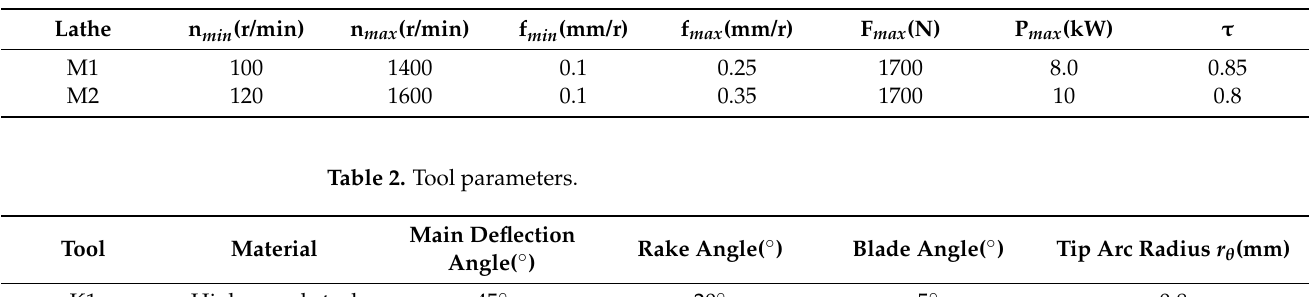
Figure 6. Flow chart of the rolling process. Table 1. Machine parameters.